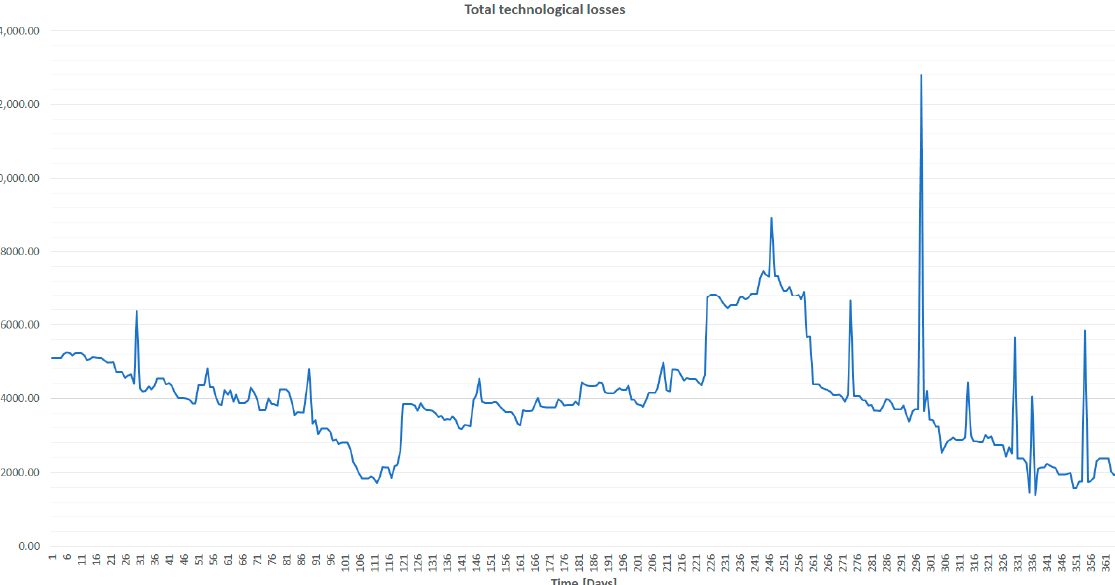
Figure 4. Technological losses in accordance to ANRE—year 2021—balance area (source: authors based on the analysed data).